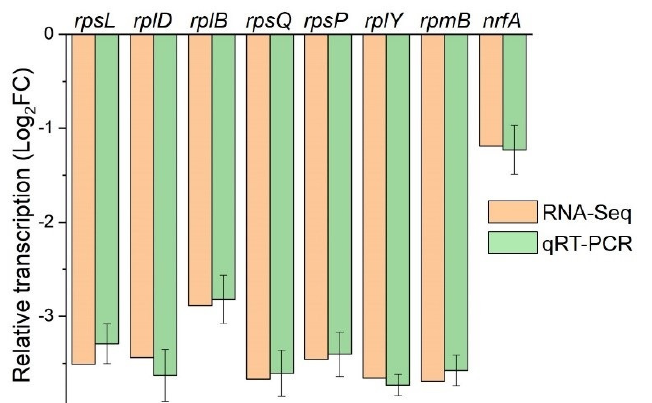
Figure 7. Transcription of representative genes that were down-regulated in Δ ygfY . Δ ygfY and WT were cultured at 16 °C for 12 h for transcriptome analysis (RAN-Seq). Transcription (log2(fold change)) of genes was examined using qRT-PCR and compared with RNA-seq data. Error bars indicate standard deviations of results from three biological replicates.